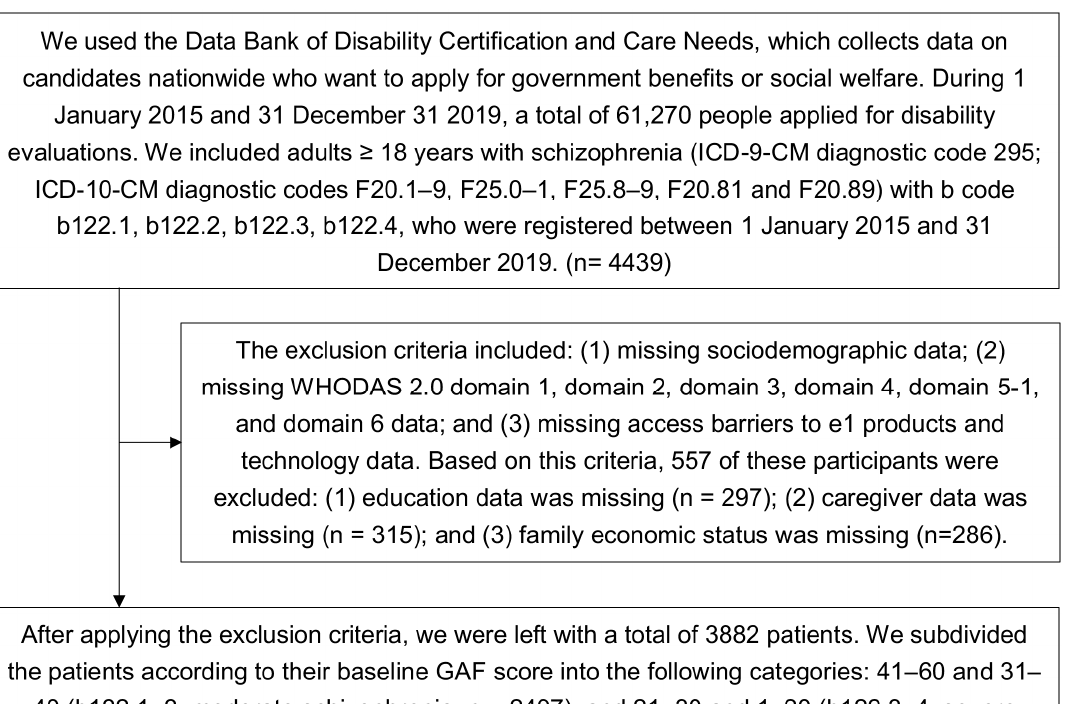
Figure 1. Flowchart of patient selection process. ICD: International Classification of Diseases; WHODAS: World Health Organization Disability Assessment Schedule; GAF: Global Assessment of Functioning.